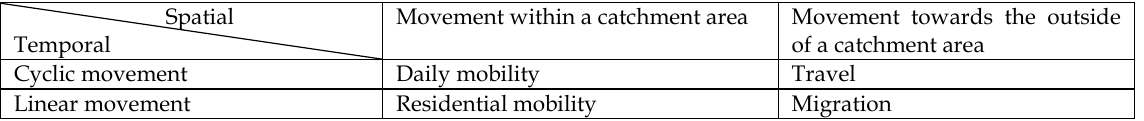
Table 1. The different geographical